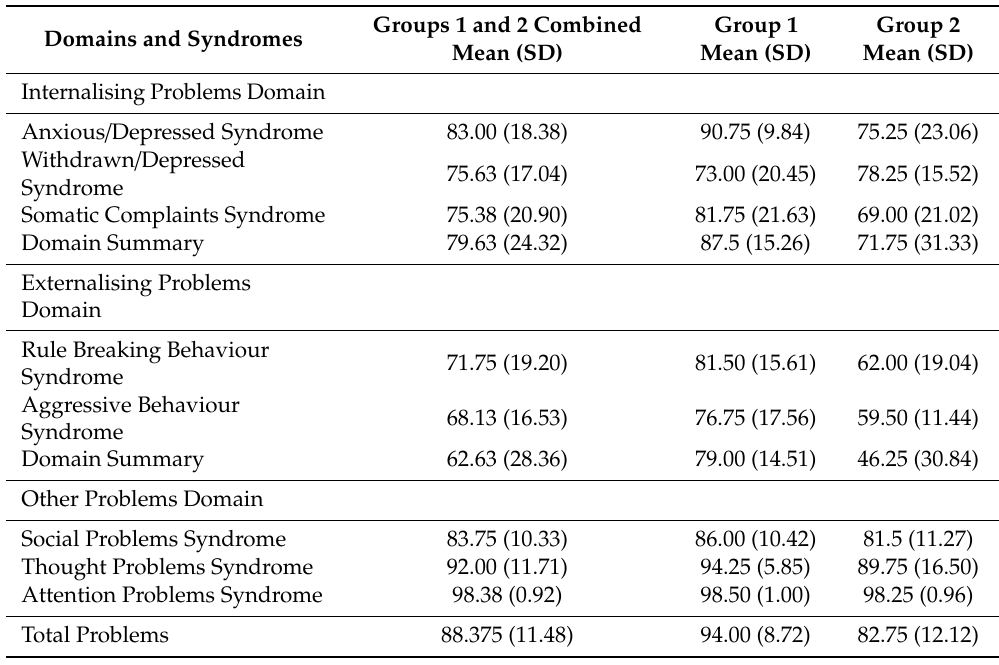
Table 4. Mean Child Behaviour Checklist percentile scores for groups 1 and 2 at baseline (week